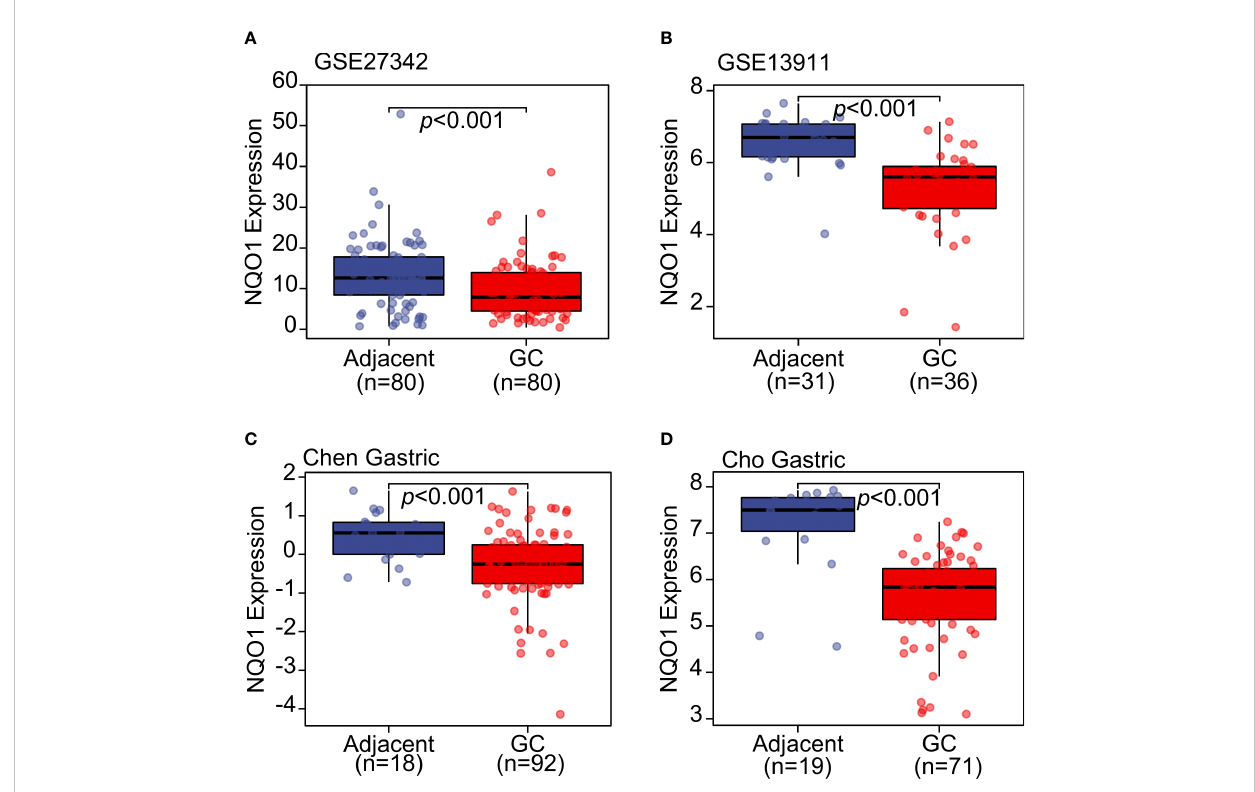
FIGURE 2 The NQO1 transcript level was downregulated in gastric cancer tissues compared with adjacent normal tissues. (A) GSE27342 and (B) GSE13911 datasets were included to evaluate the NQO1 transcript level. (C) Chen Gastric and (D) Cho Gastric datasets from Oncomine database were applied to analyze the expression level of NQO1 in gastric tumor tissues and adjacent